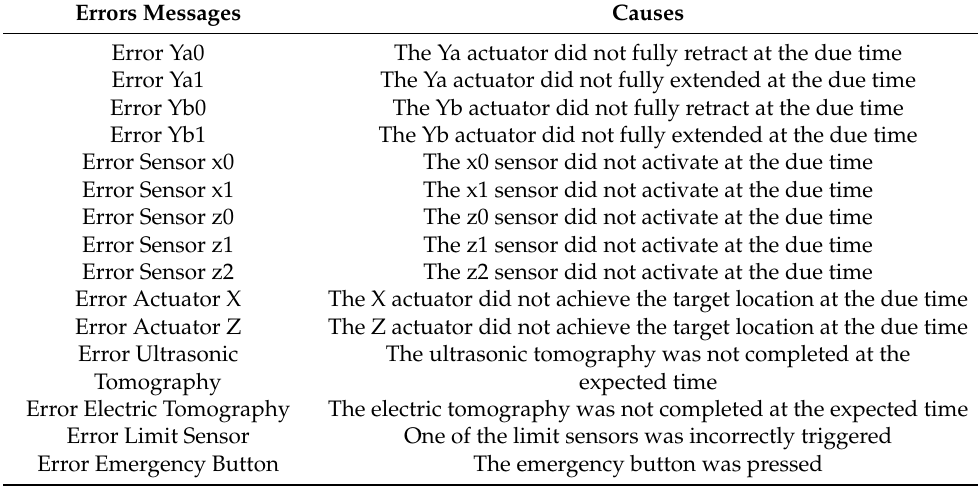
Table 4. Error messages.